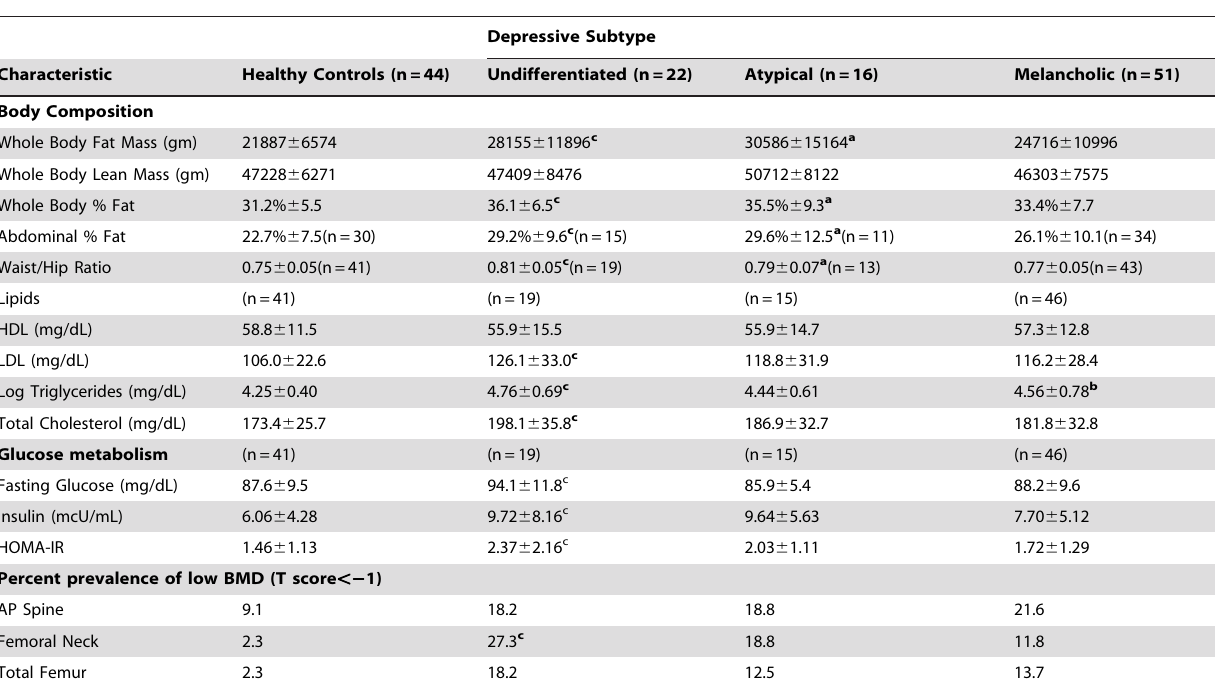
Table 3. Metabolic, body composition, and bone mineral density